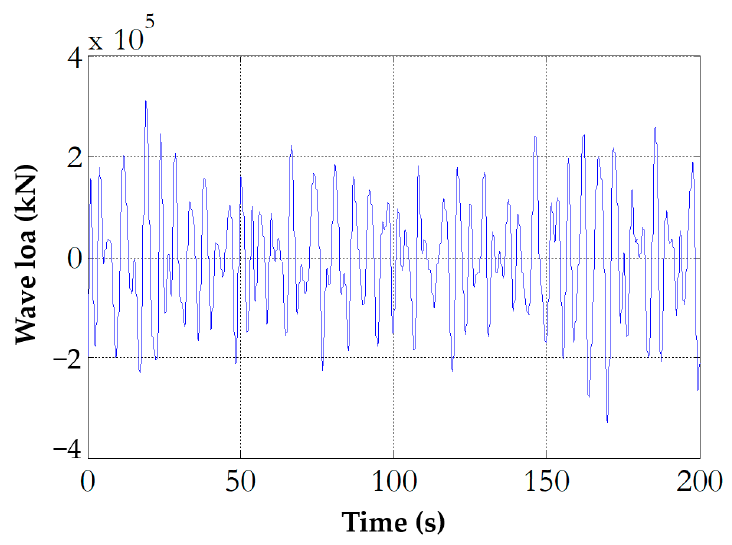
Figure 4. Wave load at mean sea